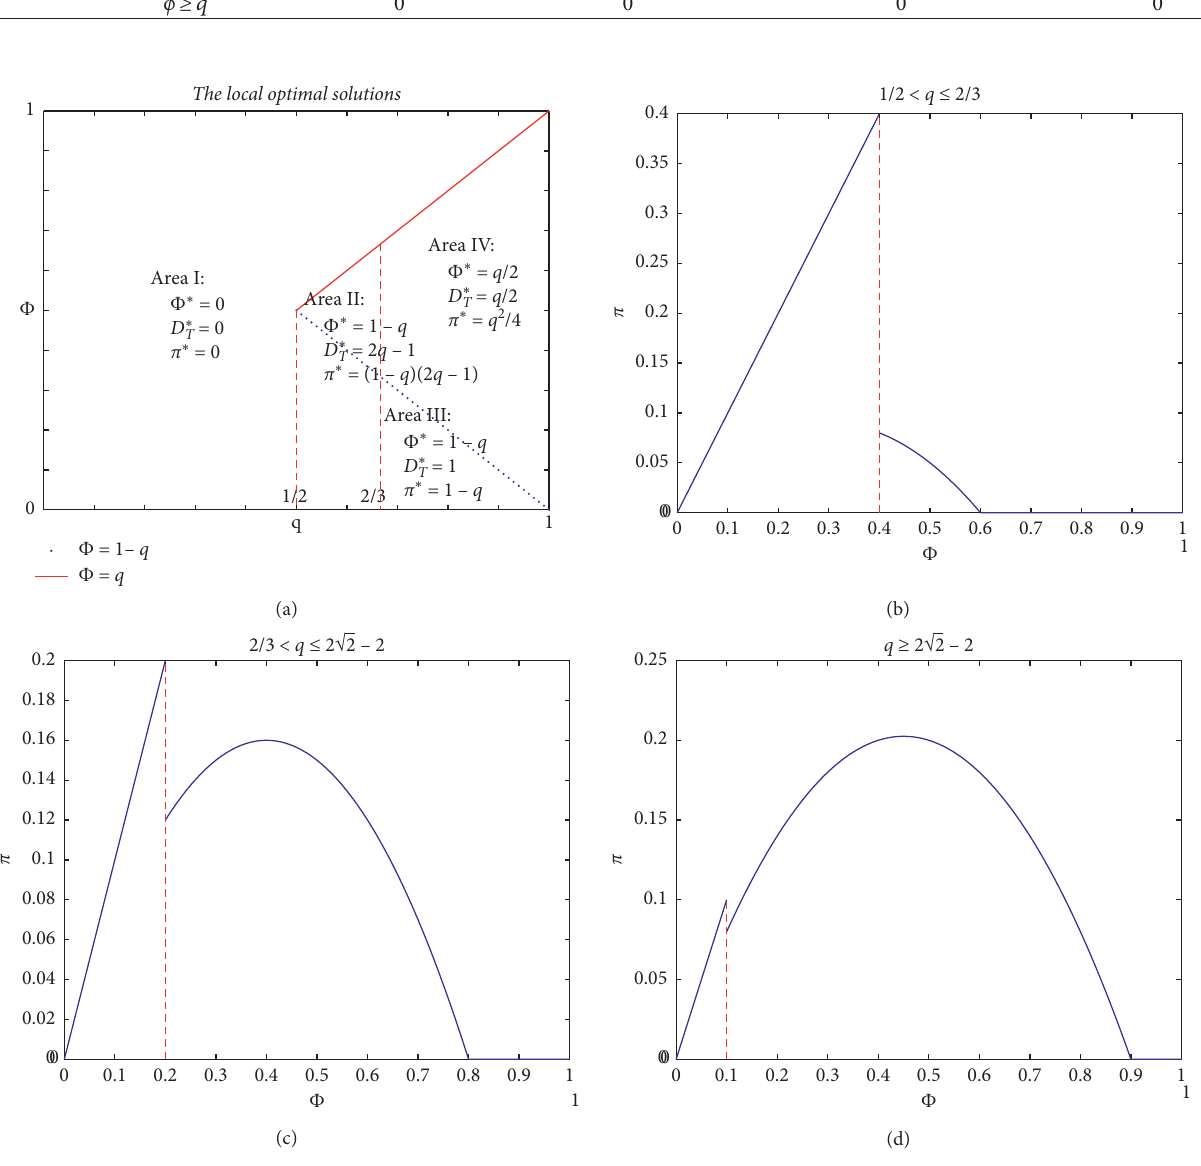
Figure 4: The local optimal solutions in different situations of certification accuracy: (a) details of decision space; (b) in the situation of 1/2 < q � 0 . 6 ≤ 2/3; (c) in the situation of 2/3 < q � 0 . 8 ≤ 2